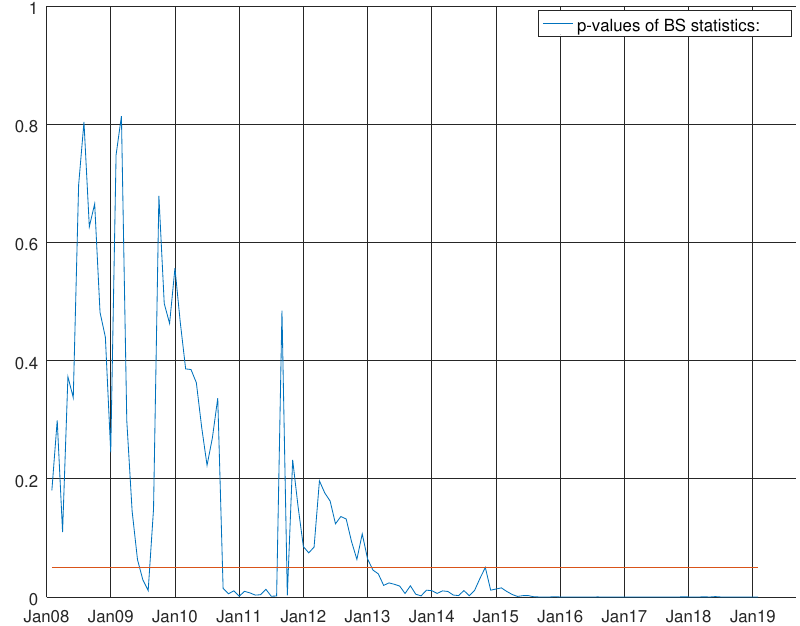
Figure 8. Graph showing the p -values of the Bowman–Shenton test for the VARMA model using the hard data only. The null hypothesis states that errors are normally distributed.